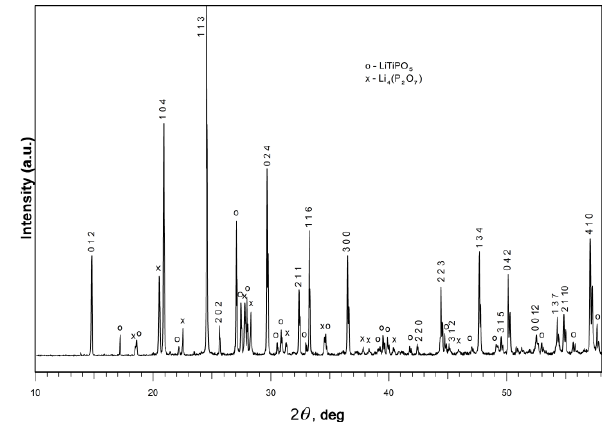
Figure 1: X-ray powder diffraction pattern